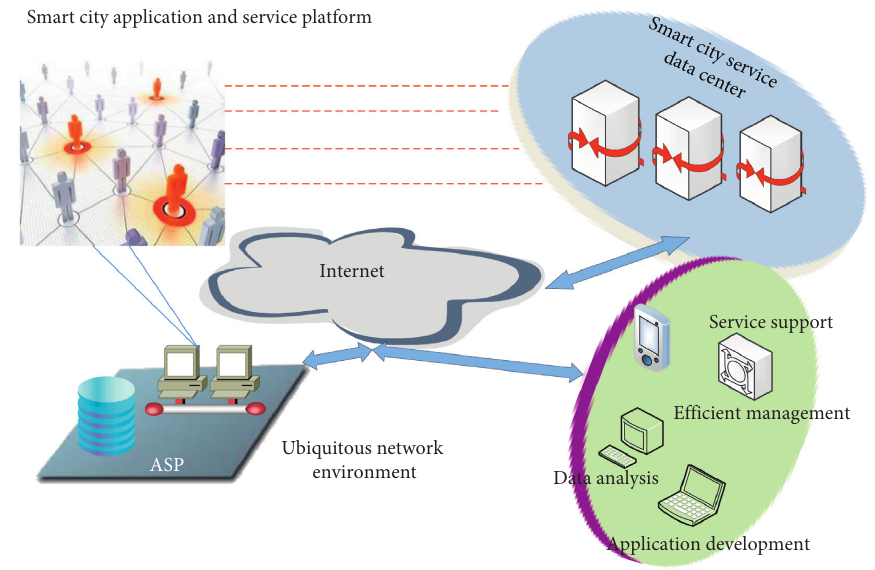
Figure 2: Smart city information service platform